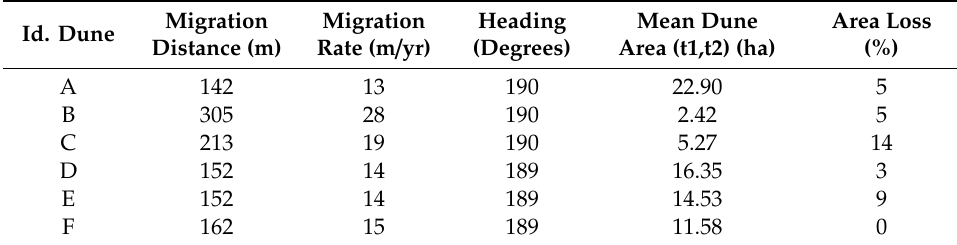
Figure 11. Figure showing the delineated dunes in green for 2003 and red for 2013 in ( A – G ) (right), the Envisat SAR image for 2003 as the background, overlaid with the outline polygons of the manually delineated dunes within yellow rectangles. Table2. Dunemigrationinformationofthe manuallydelineateddunesfromtheWestSahara-Mauritania dune field, obtained between 2003 and 2013, specifying distance, velocity, heading direction, mean area and area loss.